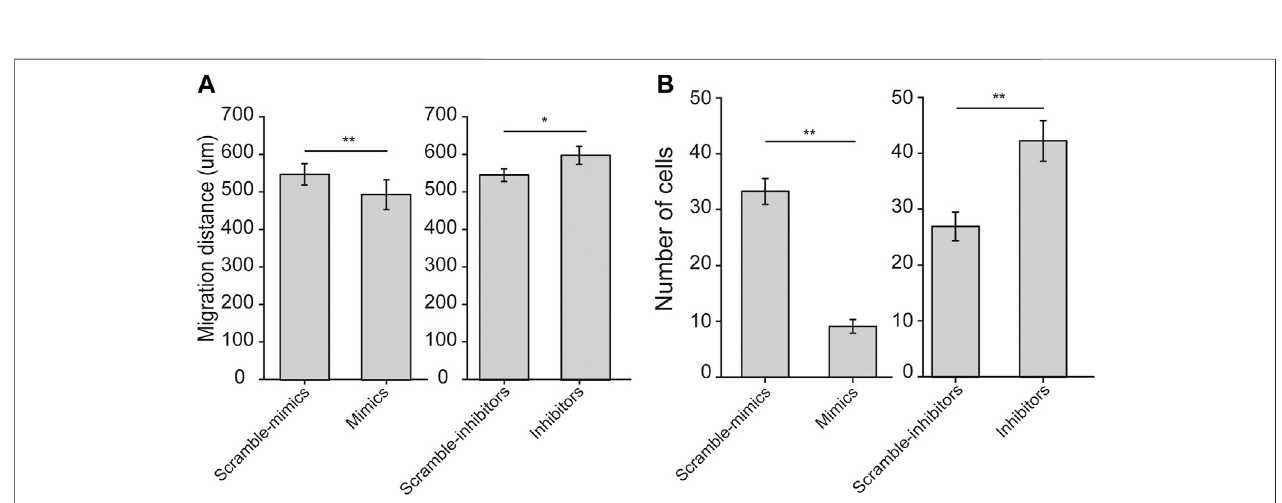
FIGURE 4 | Horizontal and vertical cell migration of ASMCs transiently transfected with let-7a-5p mimics, inhibitors, and related scramble controls measured by wound-healing and transwell assays, respectively. (A) Bar plot shows the migration distance of ASMCs at 24 h to show horizontal migration analyzed in wound healing assays. (B) Bar plot shows the number of migrated cells to show vertical migration analyzed in transwell assays. Data are means ± S.E.M., n = 3. * p < 0.05, ** p < 0.01.